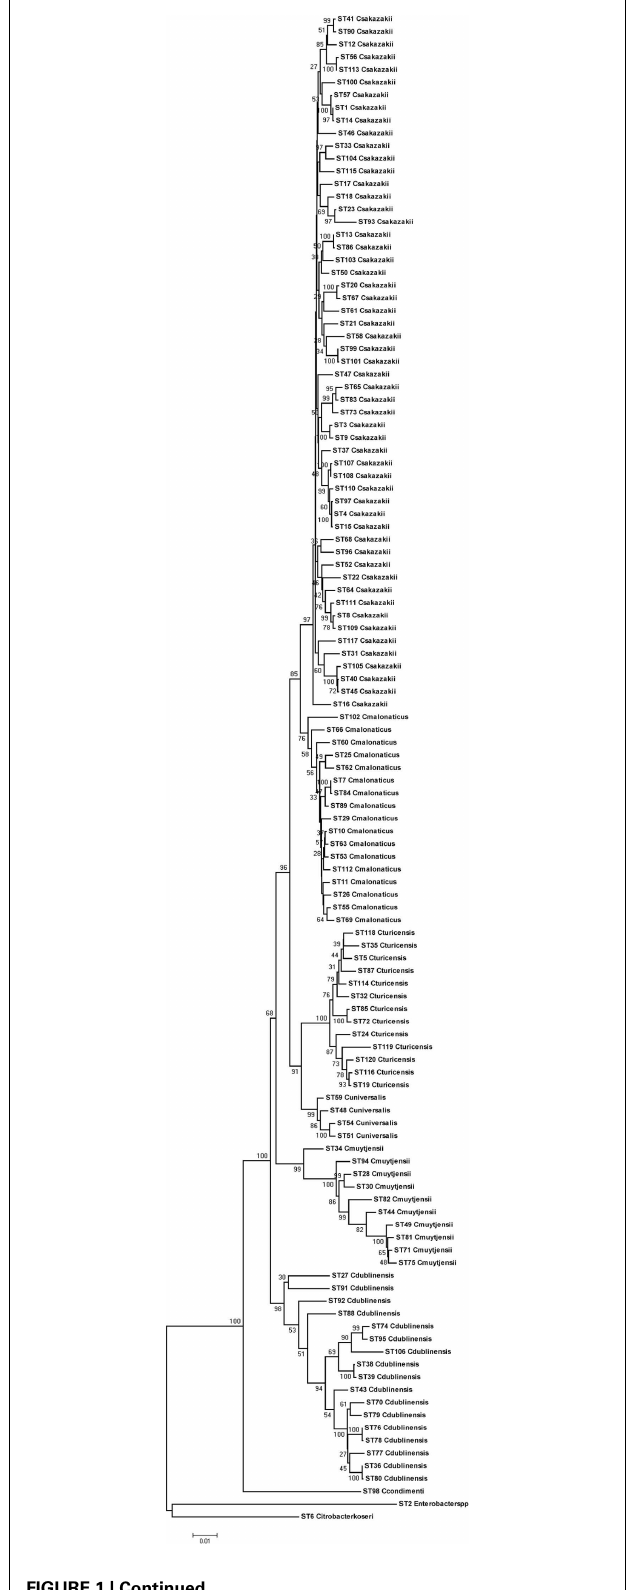
FIGURE 1 | Maximum likelihood tree based on the concatenated sequences (3036bp) of the seven LST loci for the genus Cronobacter . The STs and the corresponding species are indicated at the tip of each branch.The tree is drawn to scale using MEGA5, with 1000 bootstrap replicates.